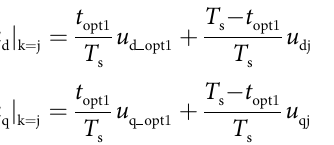
selection method. Fig 5 shows the selection of the second optimal opt2 . When V selects V , V is selected among V opt2 opt1 3 opt2